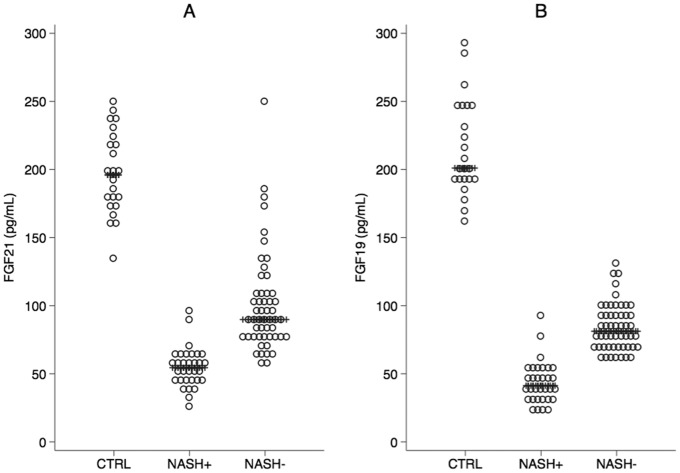
NASH and serum levels of FGF21 and FGF19.Distribution of serum FGF21 (panel A) and FGF19 (panel B) in controls, NAFLD children without NASH (NASH−) and NASH children with NASH (NASH+). Lines superimposed to dot-plots are medians.